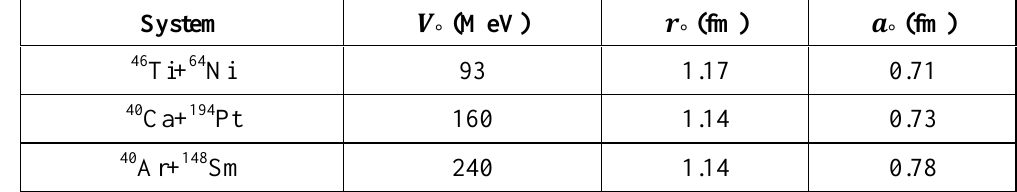
Table 1: Parameters of Wood-Saxon